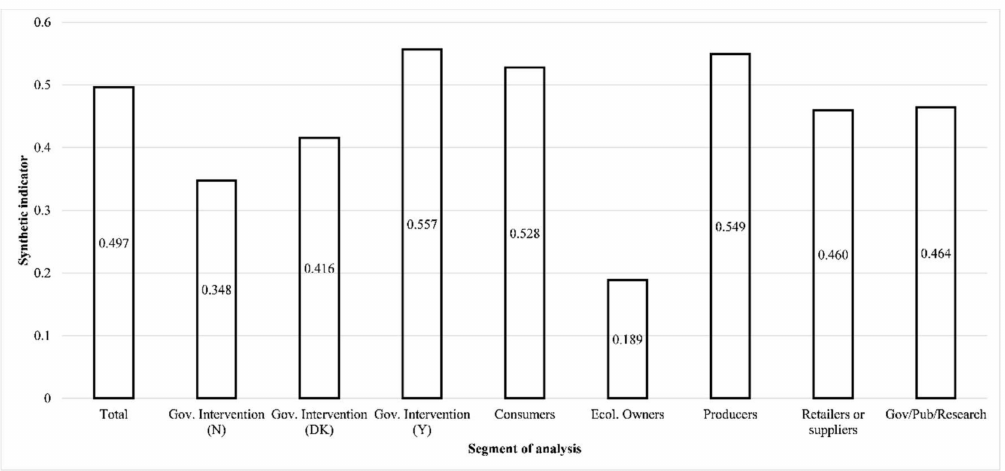
Figure 1. Level of acceptance for the inclusion of additional issues apart from environmental ones on a hypothetical EU ecolabel for the different segments of